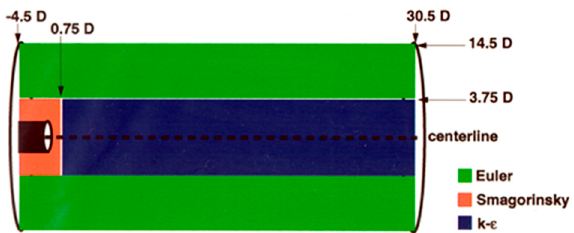
Figure 17. Very large-eddy simulation. Zones of the governing equation (Ref. [58,62]).